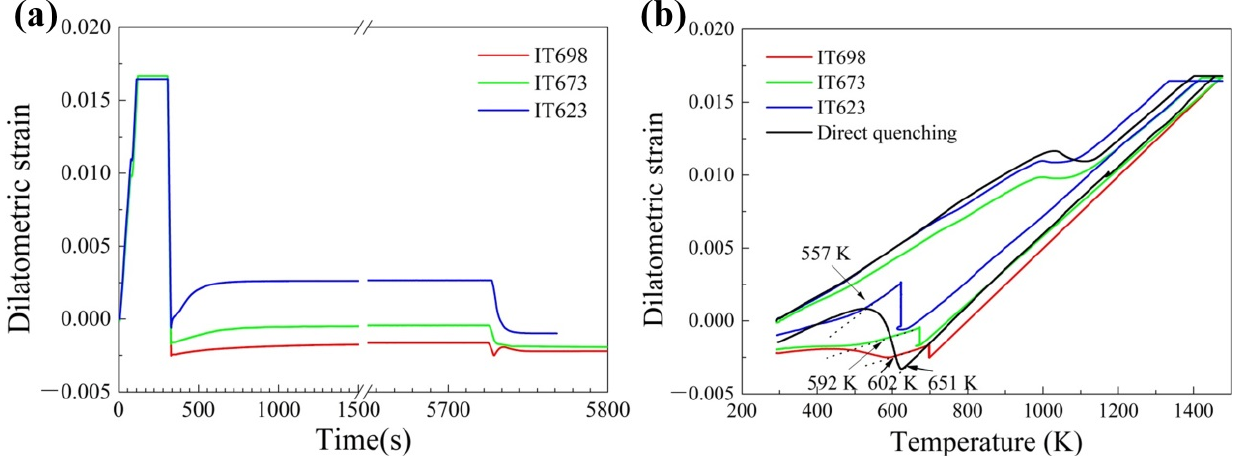
Figure 3. Dilatometric strain as a function of ( a ) time and ( b ) temperature. The arrow indicates the start temperature of martensite transformation during the final gas-quenching.